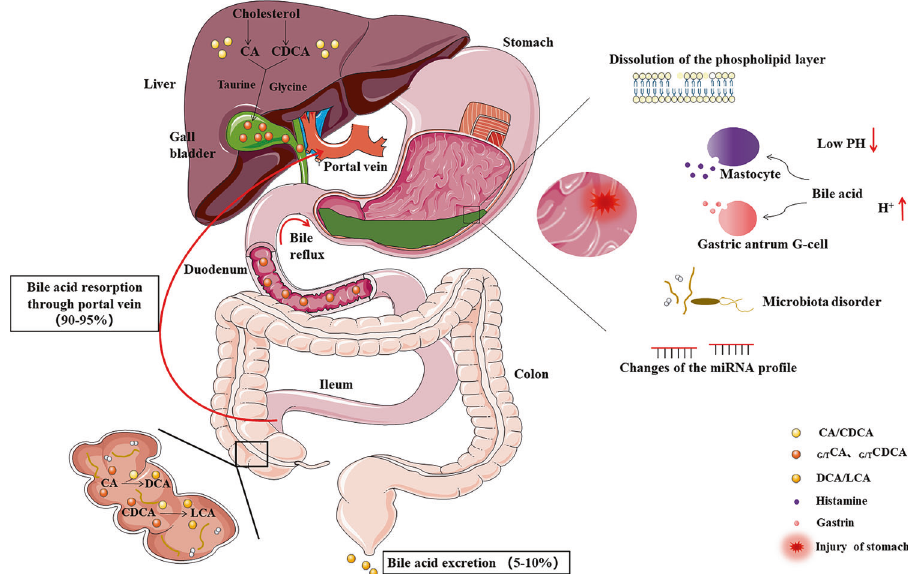
Fig. 2 Bile acid circulation and bile re fl ux. Primary bile acids (e.g., CA and CDCA) are synthesized by cholesterol mediated. They conjugated with glycine or taurine (G/T), and stored in the gallbladder. The majority (90 – 95%) of bile acid secreted into the small intestine are reabsorbed in the terminal ileum through portal vein and circulate back to the liver. Gut microbiota contributes to the conversion of CA and CDCA into secondary bile acids through dehydroxylation (e.g., DCA and LCA), which are mostly excreted from feces (5 – 10% of bile acid). Bile re fl ux to the stomach can induce mucosal dysfunction through some factors, such as dissolution of the phospholipid layer, low pH, mastocyte-secreting histamine, gastric antrum G-cell-secreting gastrin, microbiota disorder, and changes of the miRNA pro fi